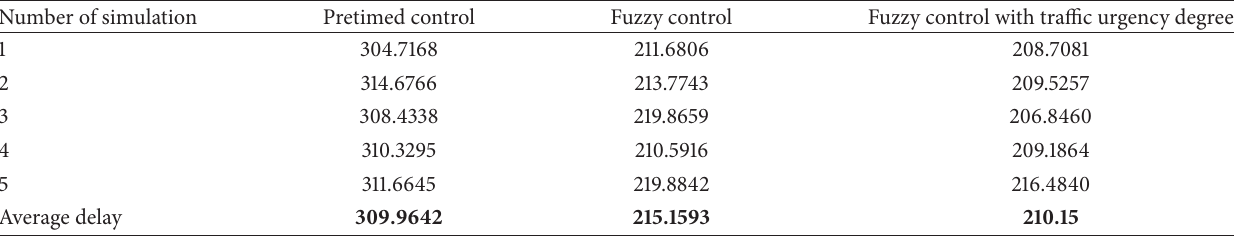
Table 5: Average vehicle delays of high traffic